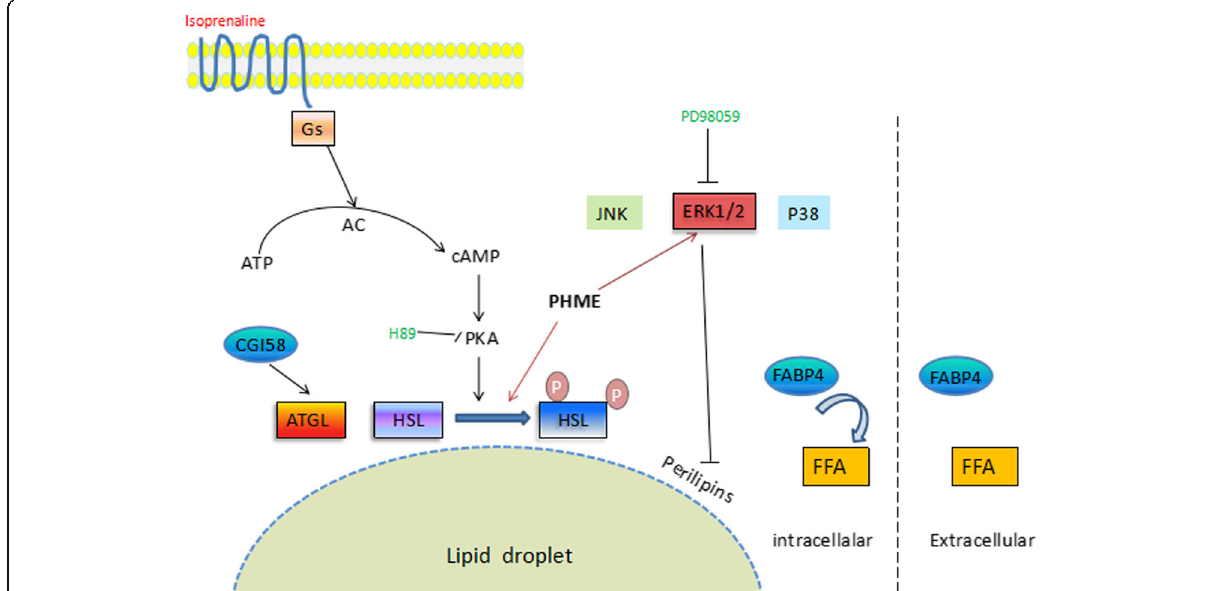
Fig. 6 Mechanisms for the lipolytic effect of PHME in 3T3-L1 adipocytes. PHME stimulates lipolysis via activating HSL and downregulating perilipin through PKA and ERK signaling